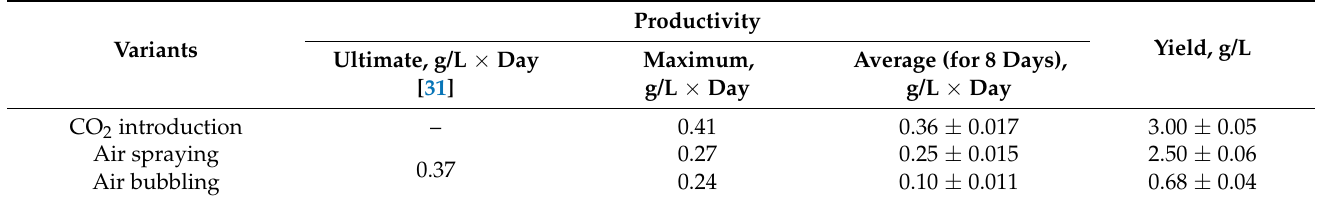
Table 1. The productivity characteristics of P. purpureum batch culture under the different methods of carbon introduction into photobioreactor (the values are means of three replicates ± ∆ x ).